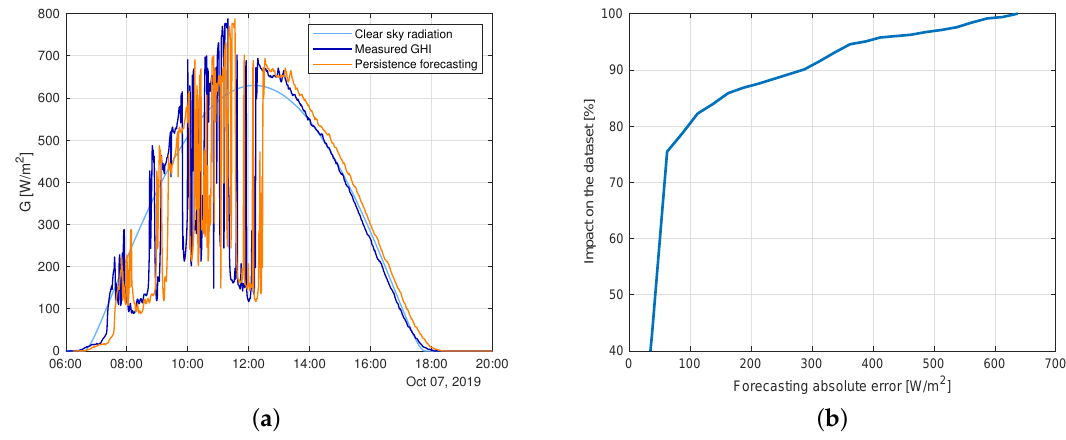
Figure 3. Persistence forecasting with 15 minutes of time horizon: irradiance values ( a ) and cumulative error plot ( b ).